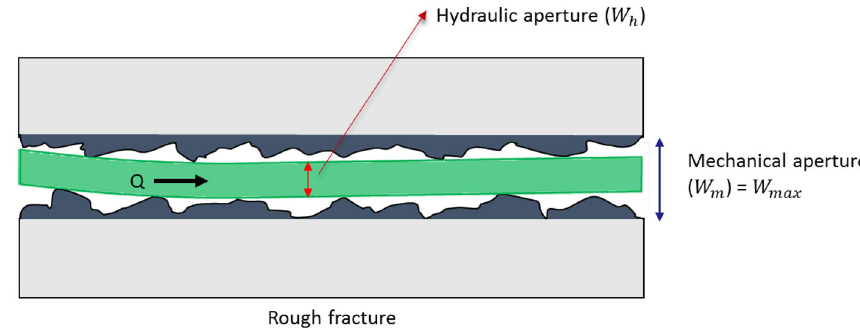
Fig. 1 A schematic